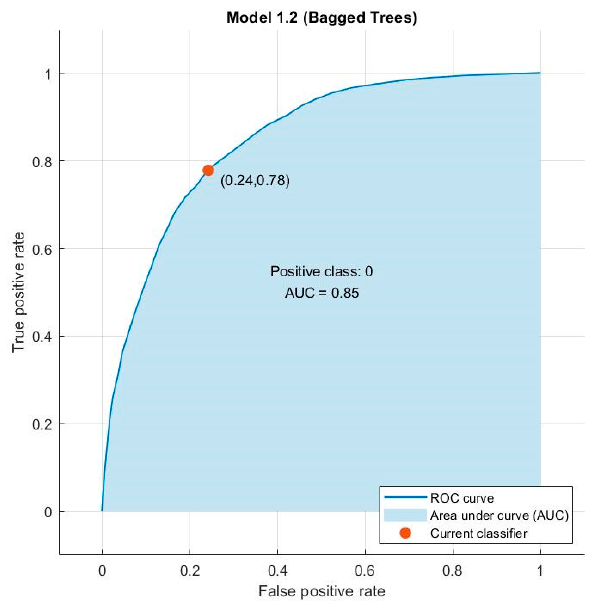
Figure 4. ROC curve of the fit of the ignition model.